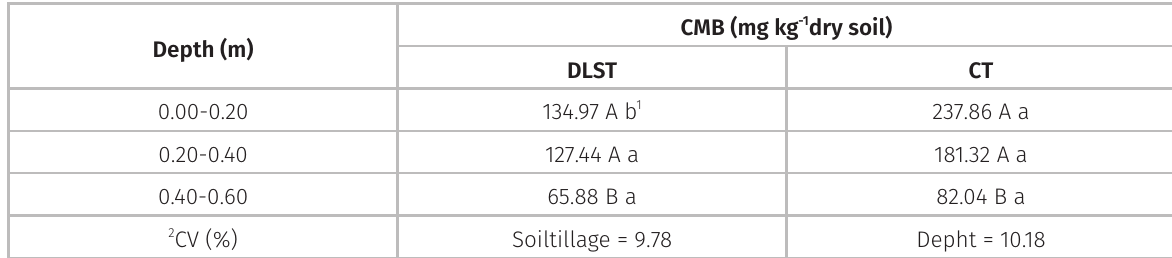
1 Means followed by different uppercase letters on the column indicate differences among depths and means followed by different lowercase letters on the row indicate differences between the soil tillage systems according to Tukey’s test (p ≤ 0.05). 2 Coefficient of